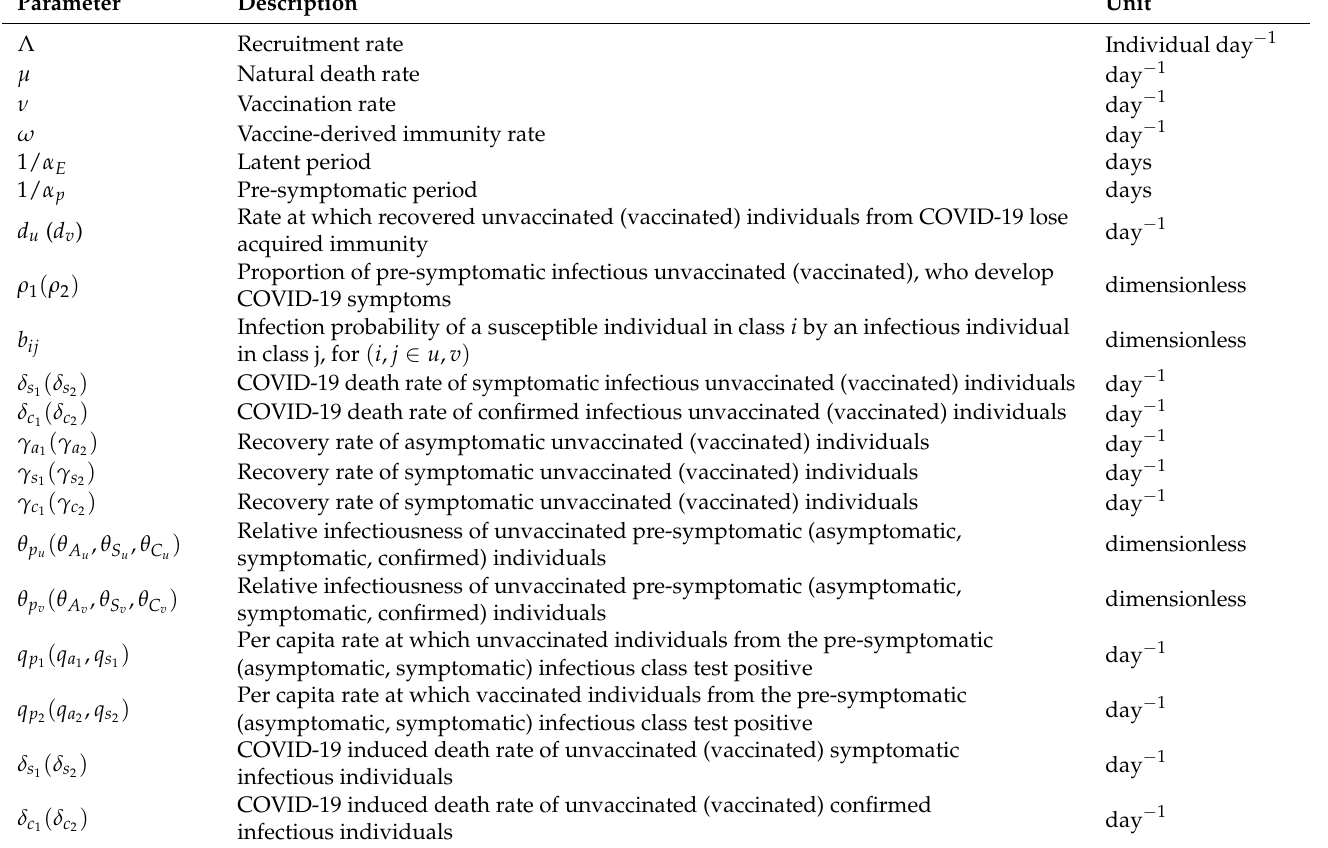
Table 2. Description of the fixed and estimated model